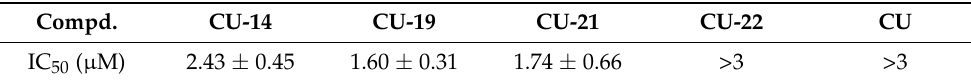
Figure 2. The ability of the active compounds to inhibit LPS-induced NO release in BV2 cells. BV2 cells were pretreated with CU-14 , CU-19 , CU-21 , CU-22 , and CU (0.3, 1.0, 3.0 μM) for 1 h and then stimulated with LPS (1 μg/mL) for 24 h. Results were the mean ± SD, n = 3; ### p < 0.001 vs. control; * p < 0.05; ** p < 0.01; *** p < 0.001 vs. LPS alone. Table 3. The IC 50 value of active compounds to inhibit LPS-induced NO release in BV2 cells. Results were the mean ± SD, n = 3.